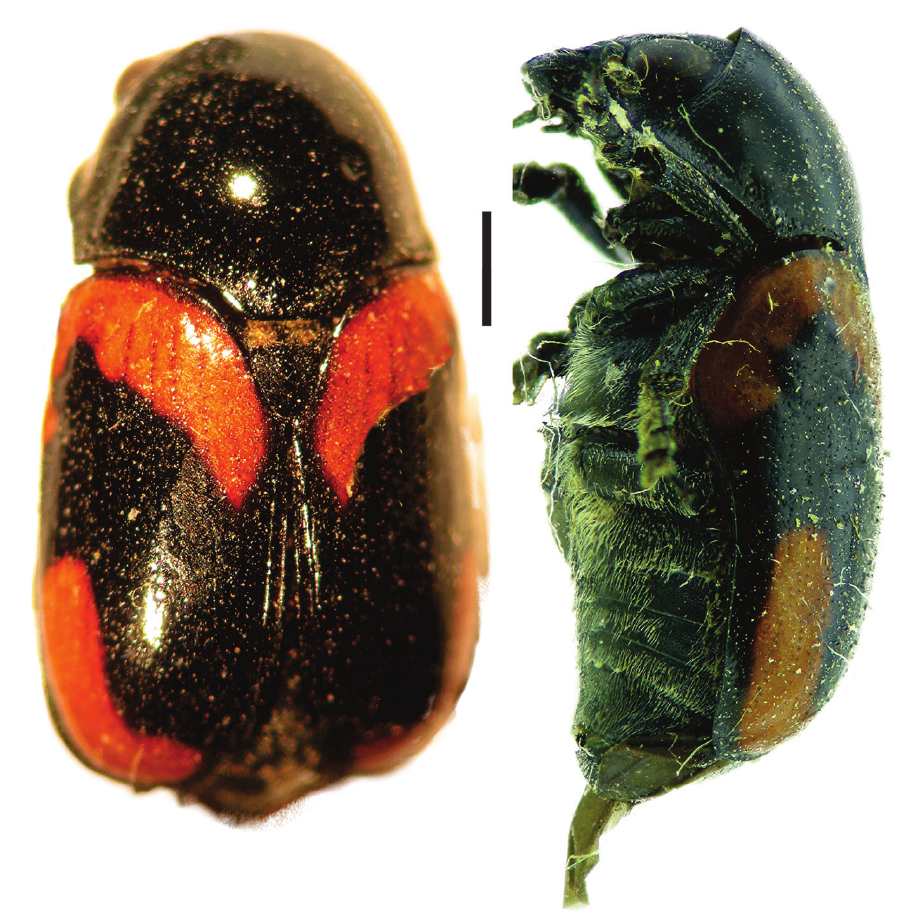
Figure 10. Paraurodera ( Paraurodera ) haematifera (Lacordaire) (1) , left: habitus (dorsal view), right: habitus (lateral